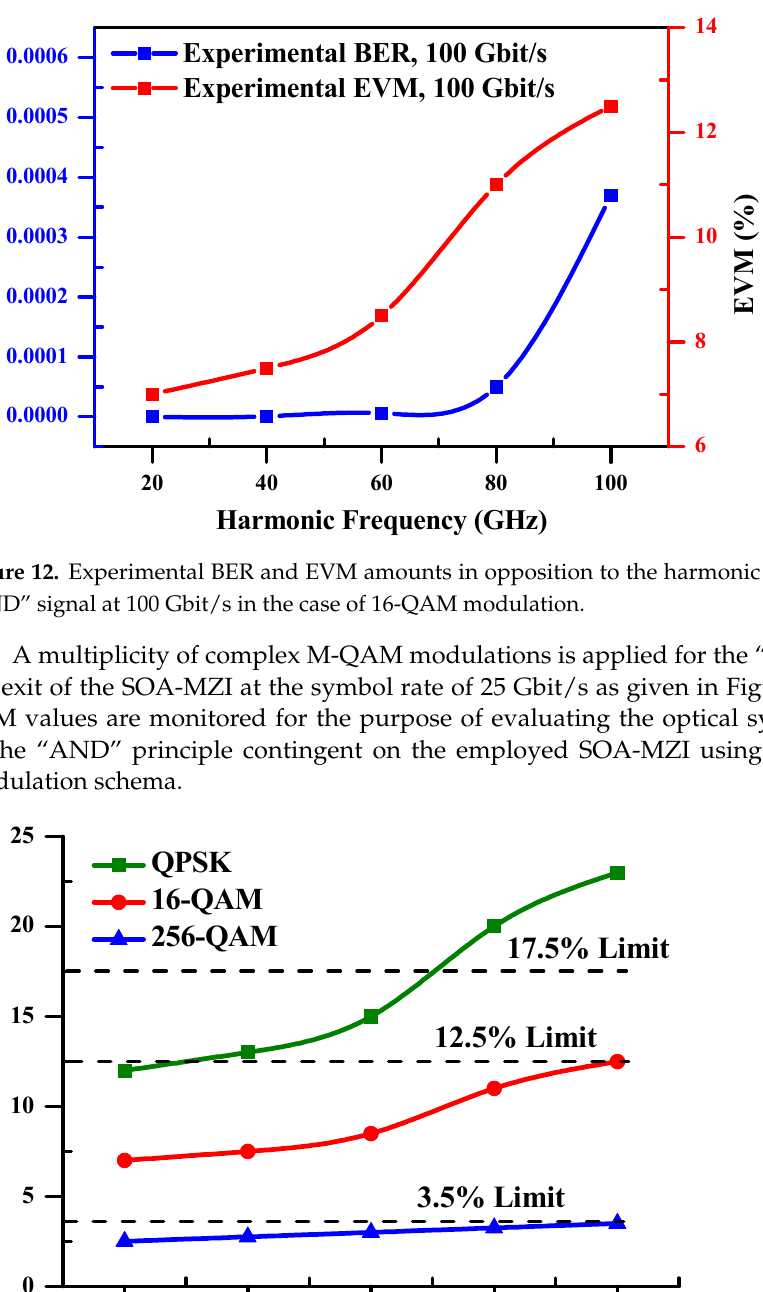
Figure 14. Constellation diagrams of the 4-QAM ( a ), 16-QAM ( b , c ), and 256-QAM ( d ) “AND” signals at the outbound port of the applied SOA-MZI. 6. Conclusions For the sake of e ffi cient performance and fl exibility, logic “AND” gates are envisaged to be advantageous in all-optical application networks. In the above article, we advance a new concept for the three-input logic “AND” gate dependent on the SOA-MZI di ff erential